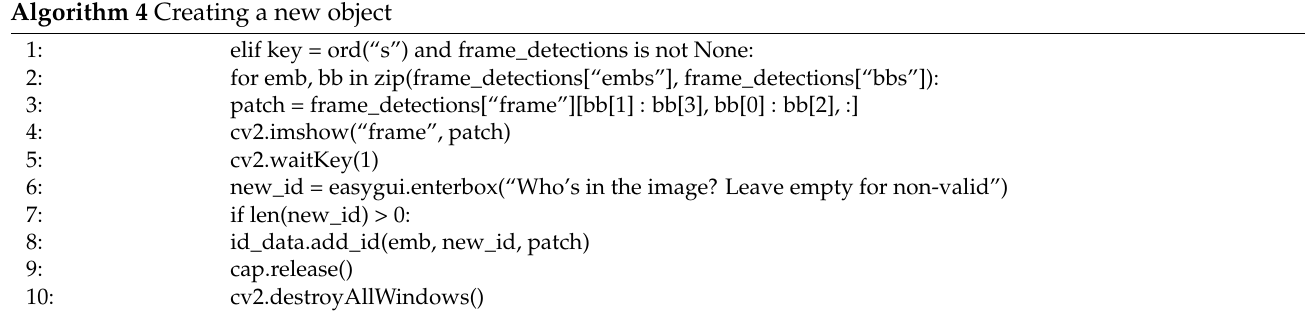
Algorithm 4 Creating a new